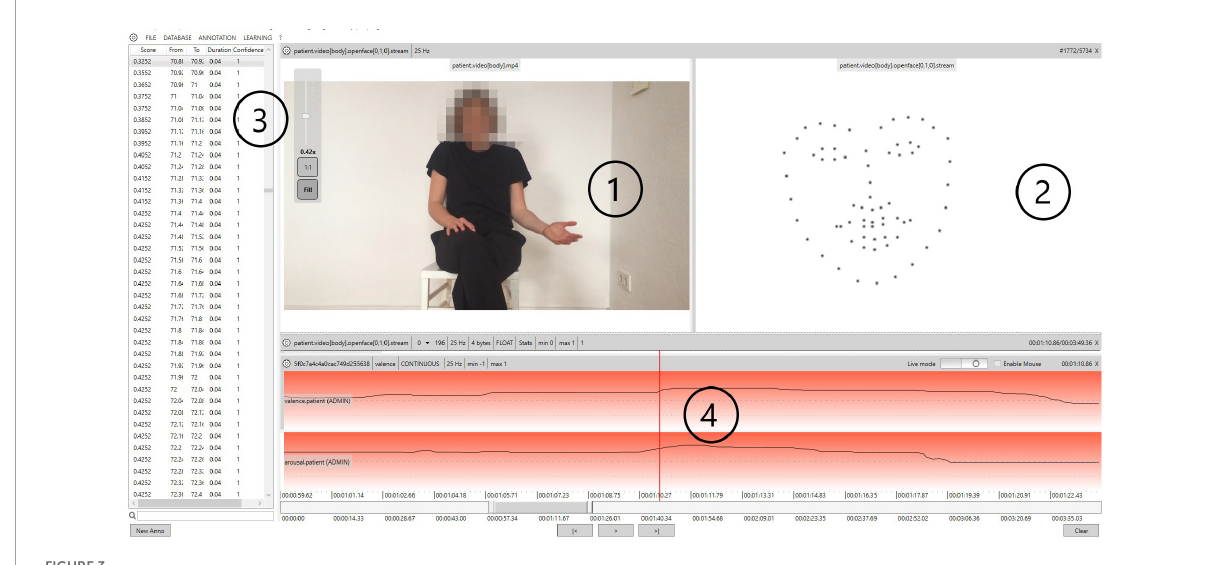
FIGURE3 Exemplary representation of therapy videos in Non-Verbal Behavior Analyzer (NOVA). 1 = original video, 2 = schematic representation of the OpenFace feature points (not shown to raters during rating), 3 = time series for arousal/valence, and 4 = graphical representation of the arousal and valence characteristics/graphical interface for the rating of